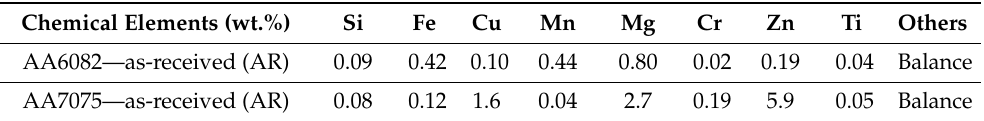
Table 1. Chemical composition of AA6082 and AA7075. Chemical Elements (wt.%)